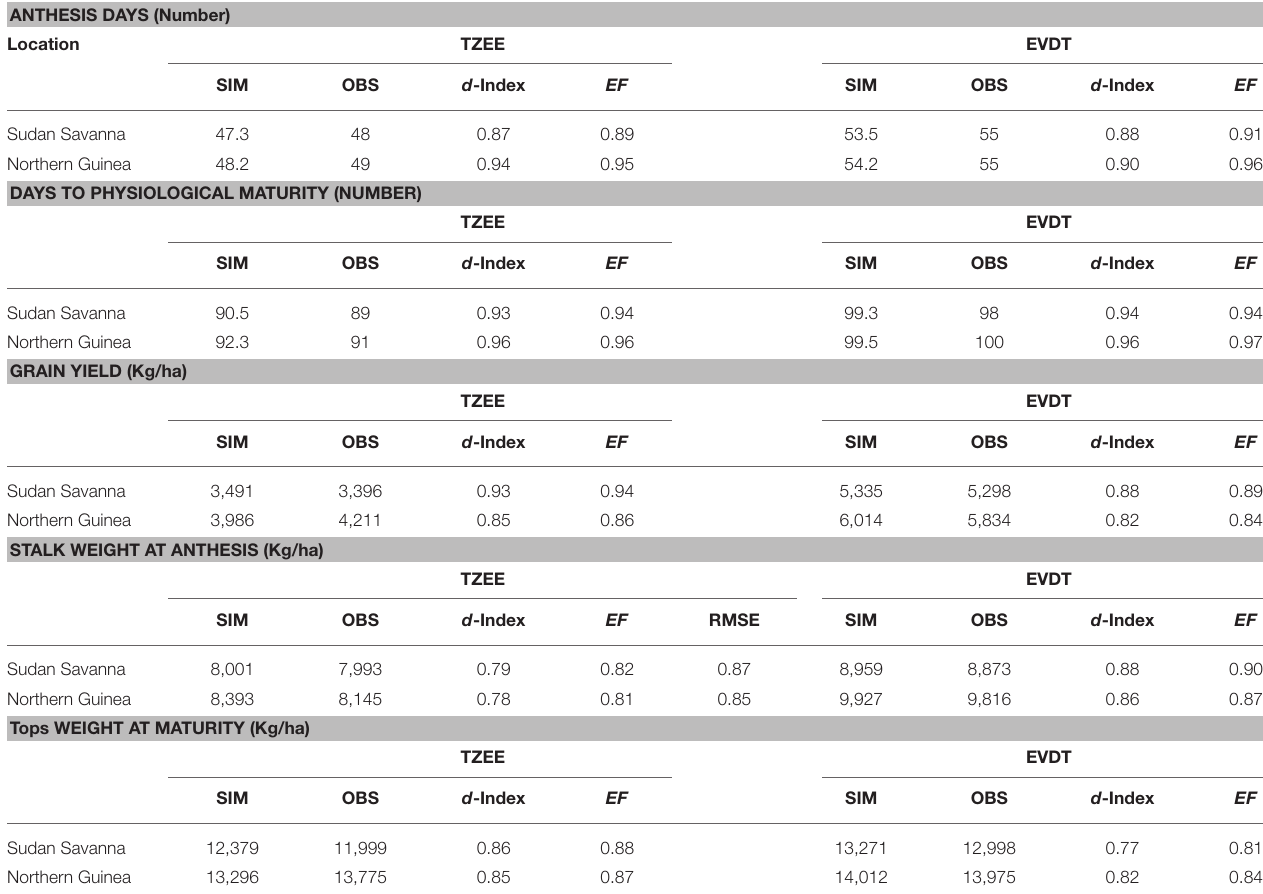
TABLE 6 | Model evaluation statistics for evaluation experiments in Sudan and Northern Guinea Savannah for EVDT and TZEE. ANTHESIS DAYS (Number)